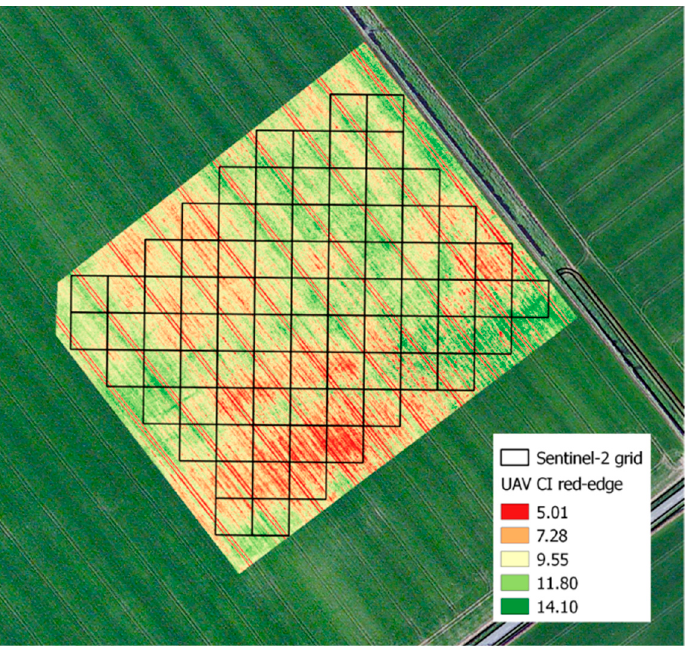
Figure 2. Sample CI red-edge image over a field on Farm 2 shown for the high-resolution (5 cm) UAV CI red-edge imagery (acquired on 23 May 2018) with an overlapping sampling grid generated from the Sentinel-2 20-m